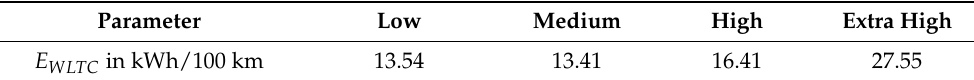
Table 6. Sectioned WLTP energy consumption data for the Kia e-Niro (charged with three phases and 16 A).